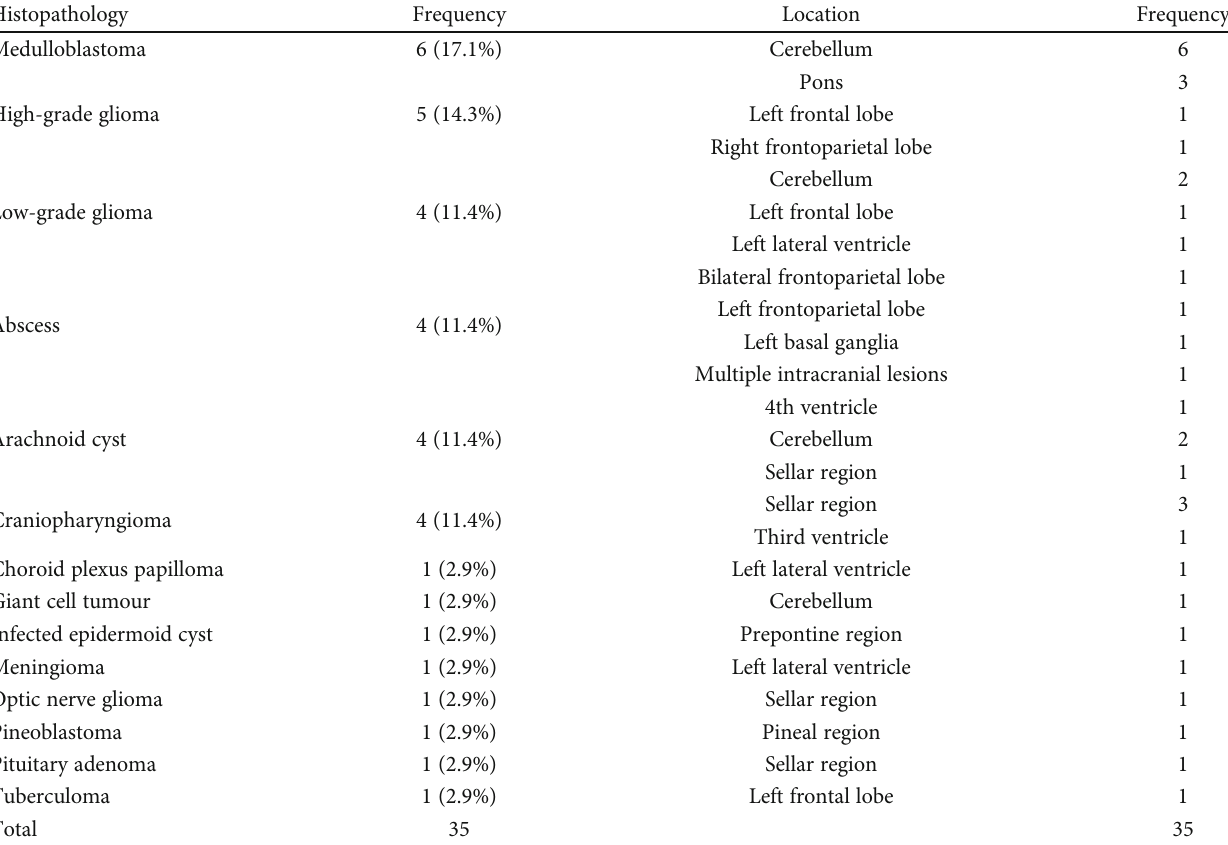
Table 5: Histopathological diagnosis and their distribution according to their